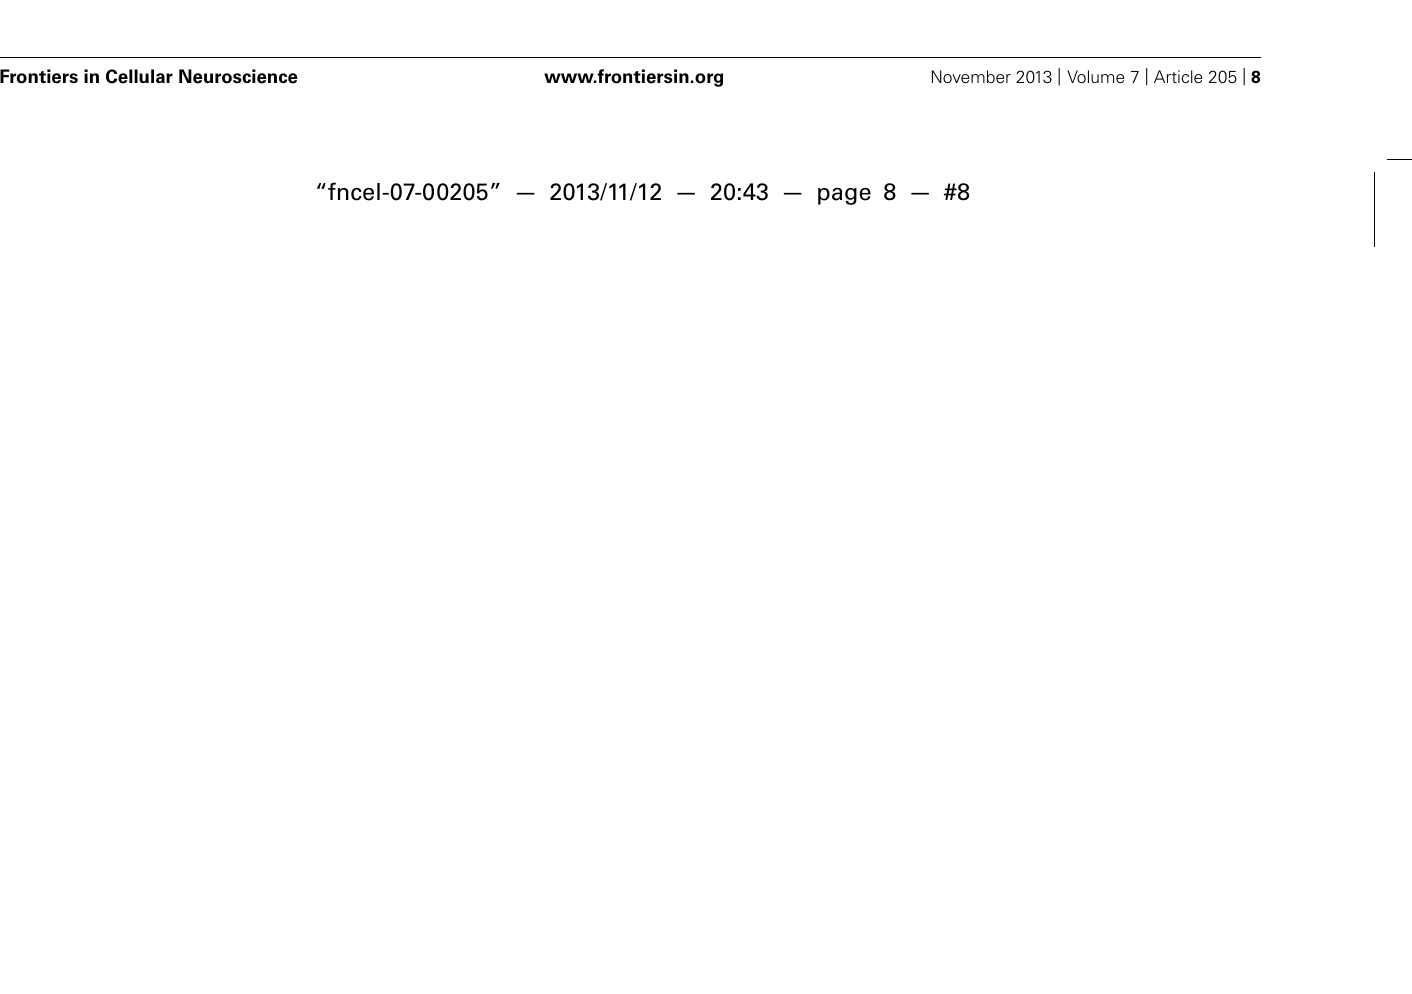
FIGURE 6 | Kv3.3b and the complex spike. (A) Examples of current clamp measurements of a CS with five spikeletes (black trace) and one with a single spikelet (gray trace). (B) Differentiation of examples shown in (A,B) . Rate of voltage fluctuation of the CS represented by the SD of the first 10 ms after the initial full action (arced line). (C) Relative expression of the housekeeping